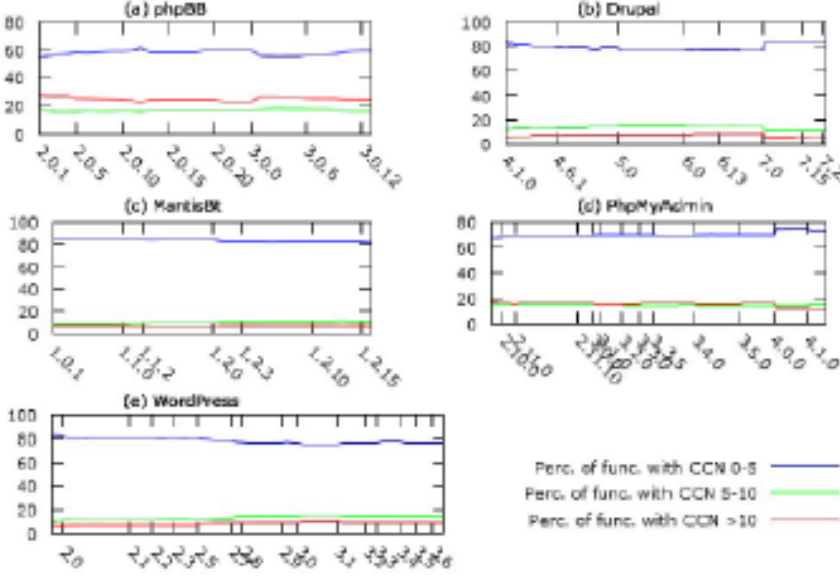
Fig. 4. Evolution of functions in three complexity ranges over